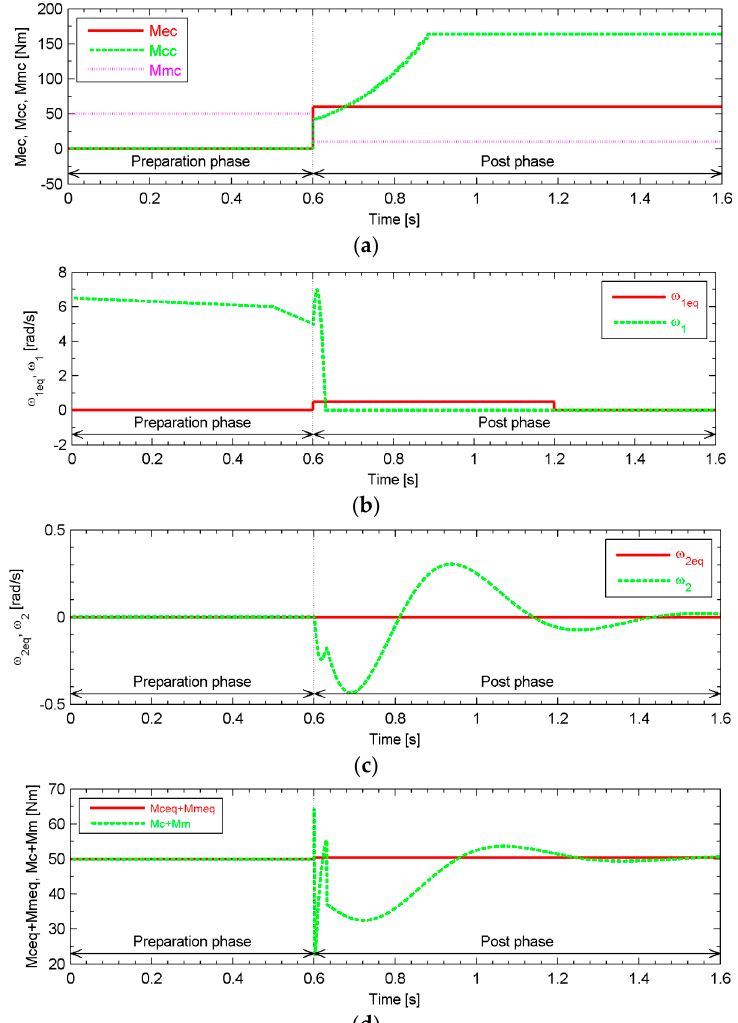
Figure 13. Scenario without DMPC. ( a ) Engine output torque command M ec , clutch torque command M cc and motor output torque command M mc ; ( b ) Equilibrium state of the clutch sliding speed ω 1 eq and clutch sliding speed ω 1 ; ( c ) Equilibrium state of the time derivative of torsion of the axle shaft ω 2 eq and time derivative of torsion of the axle shaft ω 2 ; ( d ) Torque demanded by the driver M ceq + M meq and torque supplied by the hybrid power source M c + M m